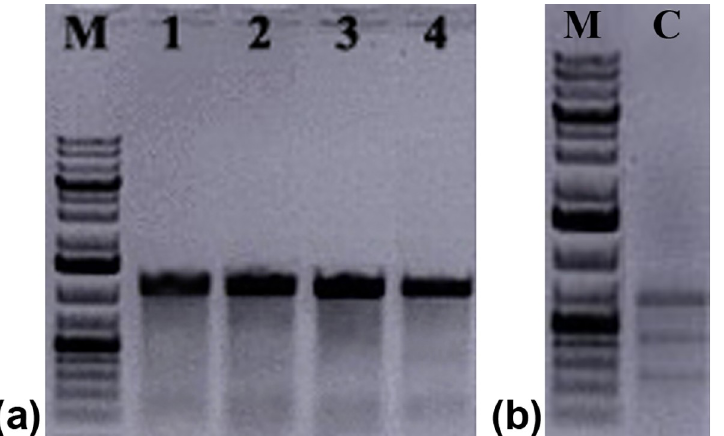
Fig 5. Detection of genome editing by T7E1 assay. a) T7EI assay from gRNA treated ChiLCV challenged plant along with ChiLCV inoculated plant. Lane M, GeneRuler 1kb plus DNA ladder. Samples in lane 1 through 4 were all amplified using primers ChiLCV-C1/V1q F &ChiLCV-IRR and then treated with T7E1. Lane 1, amplicon from mock vector treated ChiLCV inoculated N . benthamiana . Lane 2, amplicon from gRNA5+4-Cas9 construct treated ChiLCV challenged plants. Lane 3, amplicon from gRNA5+2-Cas9 construct treated ChiLCV challenged plants. Lane 4, amplicon from gRNA1+2-Cas9 construct treated ChiLCV challenged plants. b) Control heteroduplex DNA (C) from the kit showed cleavage of the control heteroduplex by the